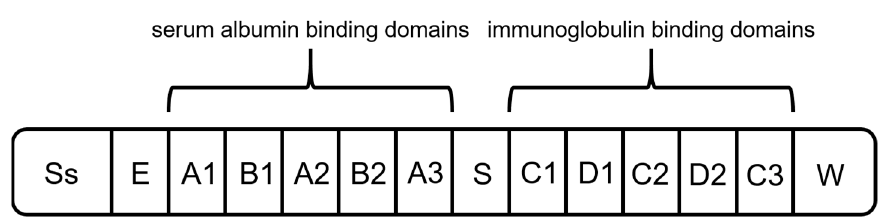
Figure 5. Schematic structure of protein G. It is composed of a signal peptide (Ss), an alanine-rich region (E), an albumin-binding site, an immunoglobulin-binding site, and a cell-wall anchoring region (W) [65] .